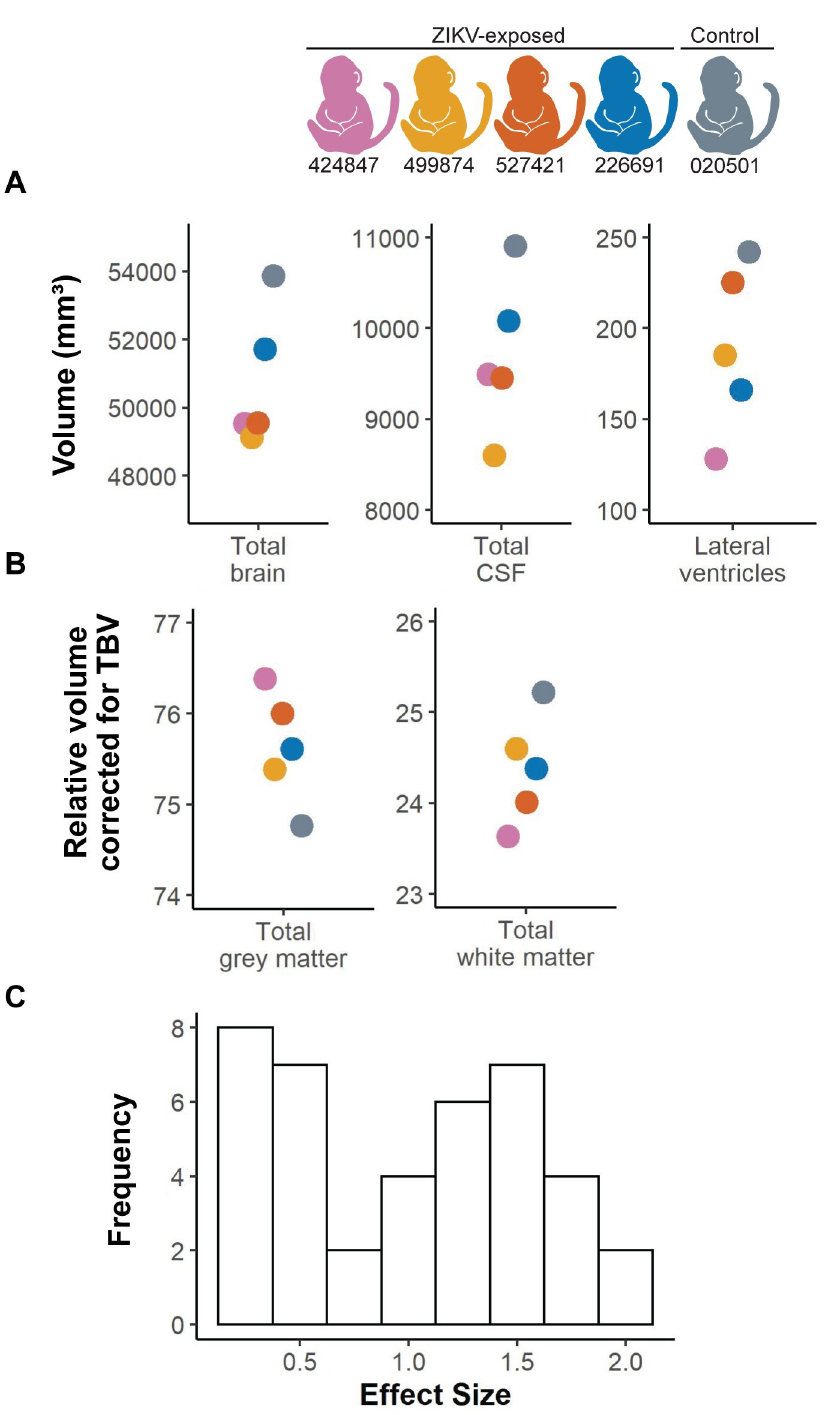
Fig 11. Volumetric brain analysis and effect sizes. (A) Structural MRI measurements in cubic millimeters for total brain volume (TBV), lateral ventricles and cerebrospinal fluid (CSF). (B) Grey matter and white matter specific areas corrected for TBV in all infants. (C) A histogram illustrates the distribution of effect for entire brain regions and regions corrected by TBV (tissue type, cortical regions, subcortical regions).